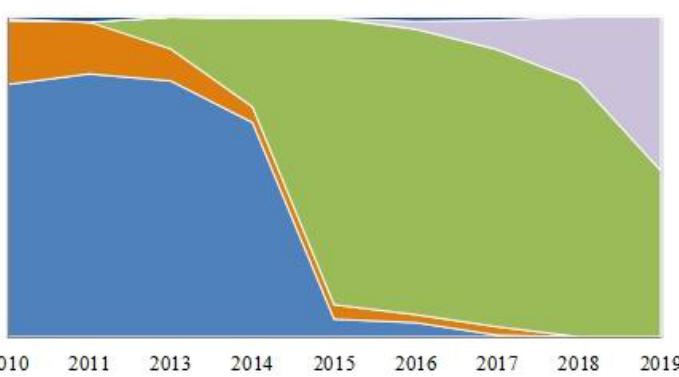
Figure 1. First-line prescription trend over time in non-penicillin-allergic patients. Relative fre- quencies per year are represented. PCA: PPI + Clarithromycin + Amoxicillin. PCAM: PPI + Clar- ithromycin + Amoxicillin + Metronidazole. PLA: PPI + Levofloxacin + Amoxicillin. PPylera ® : PPI + Pylera ® .